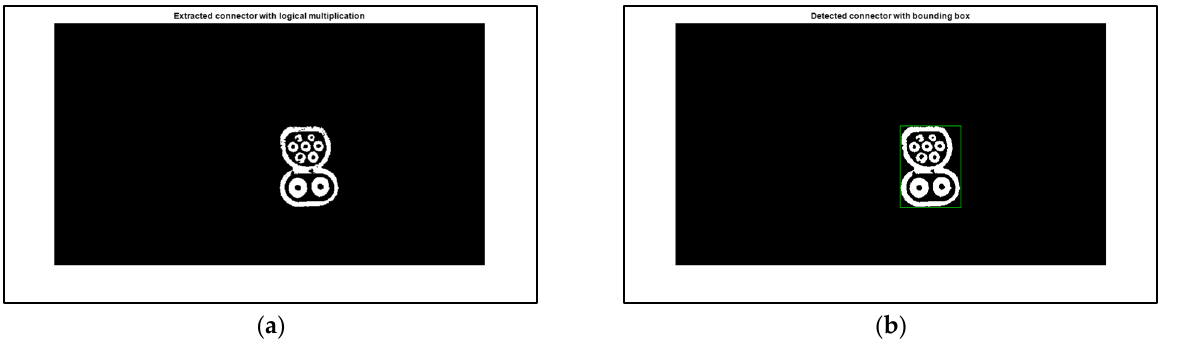
Figure 8. ( a ) Result of the extraction with logical image multiplication and ( b ) result of the sequence of morphological post-processing.